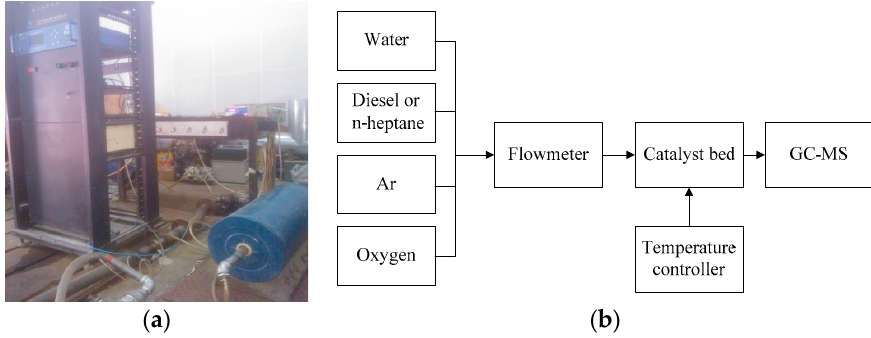
Figure 2. Catalytic reformer setup: ( a ) Catalytic reforming reactor ( b ) Schematic of reforming experimental set-up.